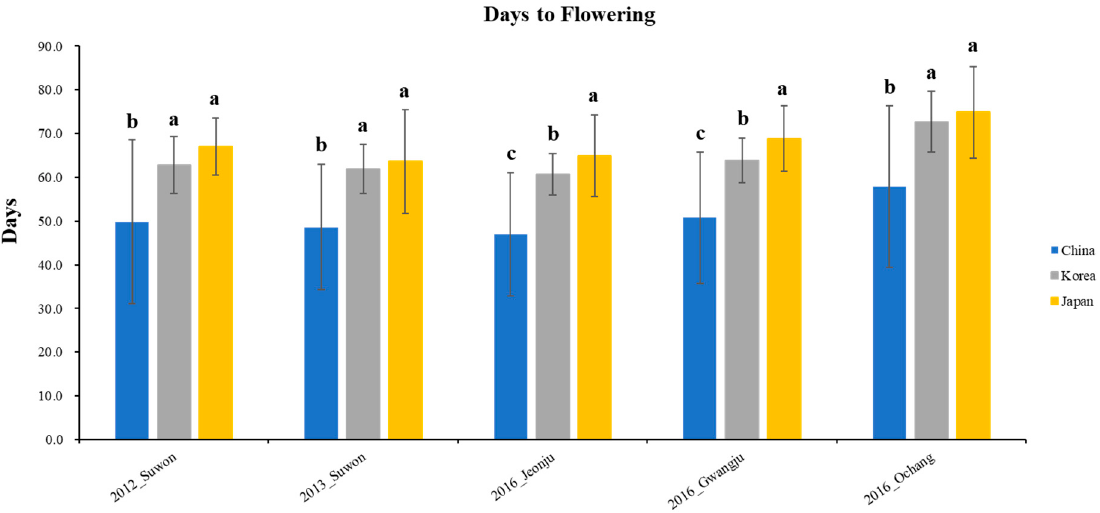
Figure 5. Phenotypic distribution for days to flowering with 408 core collections in 5 environments. The Korean, Chinese, and Japanese clusters are indicated in gray, blue, and yellow, respectively. Bars indicate standard deviation. LSD is the least square difference between clusters in five different environments, and different characters on bars indicate 5% significance level.